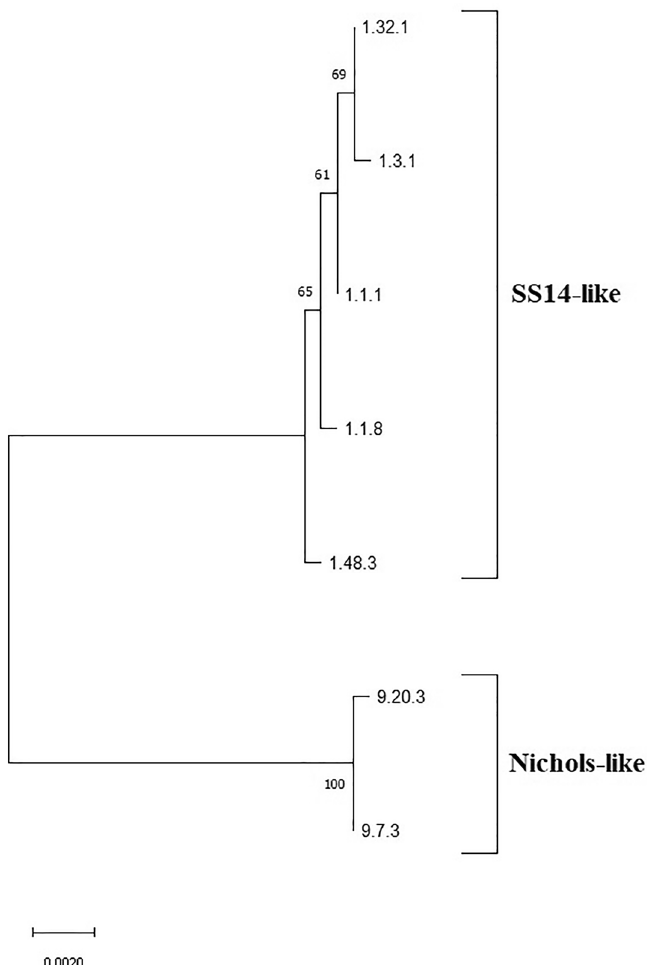
Figure 2. Majority rule consensus tree of 1000 bootstrap replicates performed on concatenated TP0136, TP0548 and TP0705 sequences identified among fully typed samples. Bootstrap percentages given for clades recovered with more than 50% support. The scale shows the number of substitutions per site. Bootstrap values are shown next to branches. The length of concatenated sequences was 1901 bp and contained 44 variable positions. The tree was constructed in MEGA X 52 using the Maximum Likelihood method 54 with the bootstrap test 55